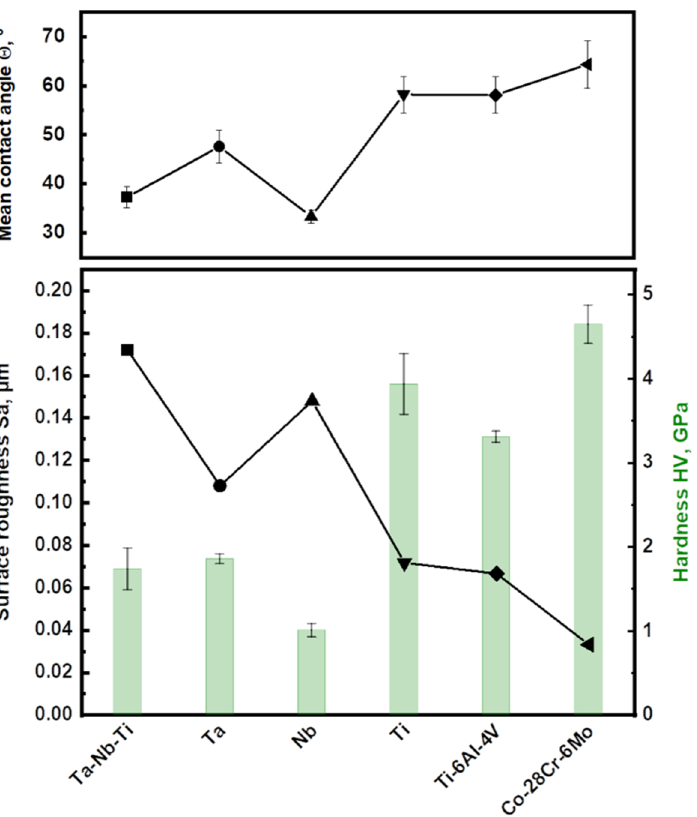
Figure 5. Presentation of the obtained surface parameters (surface roughness Sa and mean contact angle) in comparison with the microhardness analysis of the equiatomic alloy Ta-Nb-Ti, the respective elements and other biomedical implant materials.